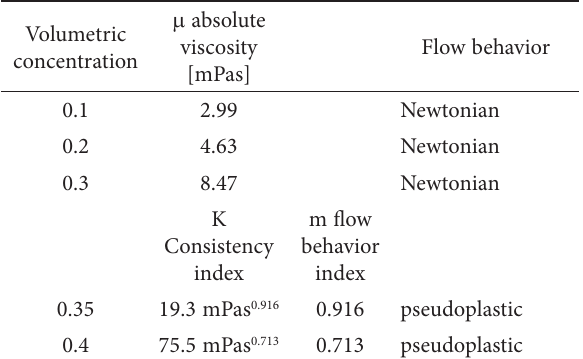
Fig. 3. Flow curves of sand glass from Fehérvárcsurgó Table 2. Flow properties of sand glass from Fehérvárcsúrgó (5 ... 30 m m, r = 2644 kg/m 3 ) s